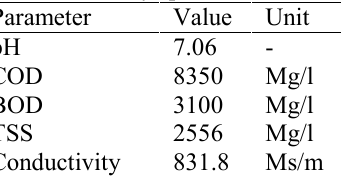
Table 1. Quality specifications of the raw leachate Parameter Value Unit